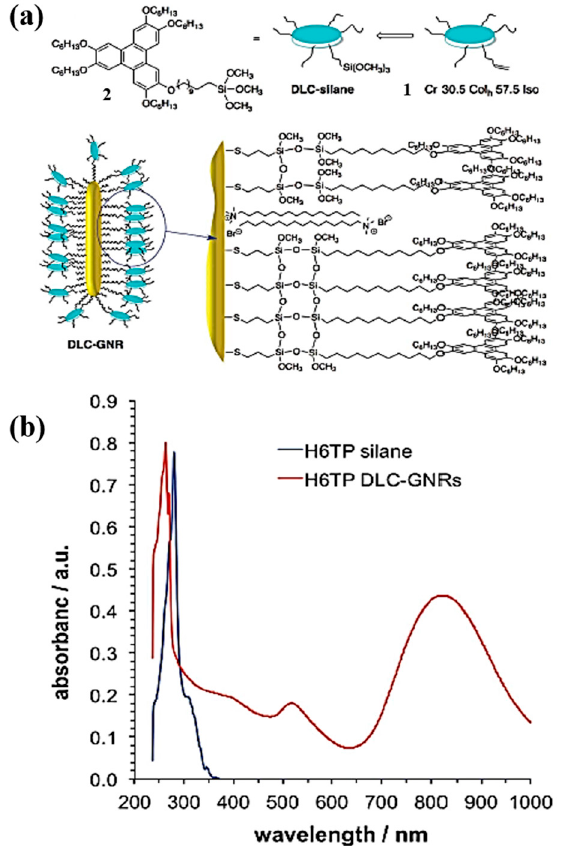
Figure 3. ( a ) Molecular structure of discotic mesogen bearing terminal silane precursor 2 and respective phase-transition temperature of the DLC silane precursor 1 and silane 2 along with 2D schematic representation of DLC-functionalized GNRs; ( b ) UV-Vis-NIR spectra of the TP DLC silane 2 and the TP DLC-GNRs. Reproduced with permission [91].